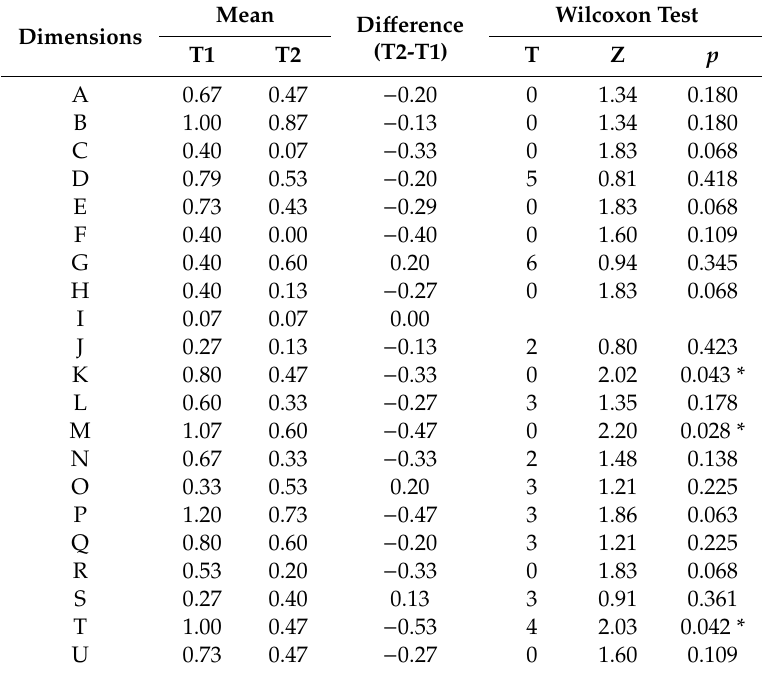
Table 6. Qualitative di ff erences in particular dimensions from Beck’s Depression Scale (BDI) for the relaxation group (R).